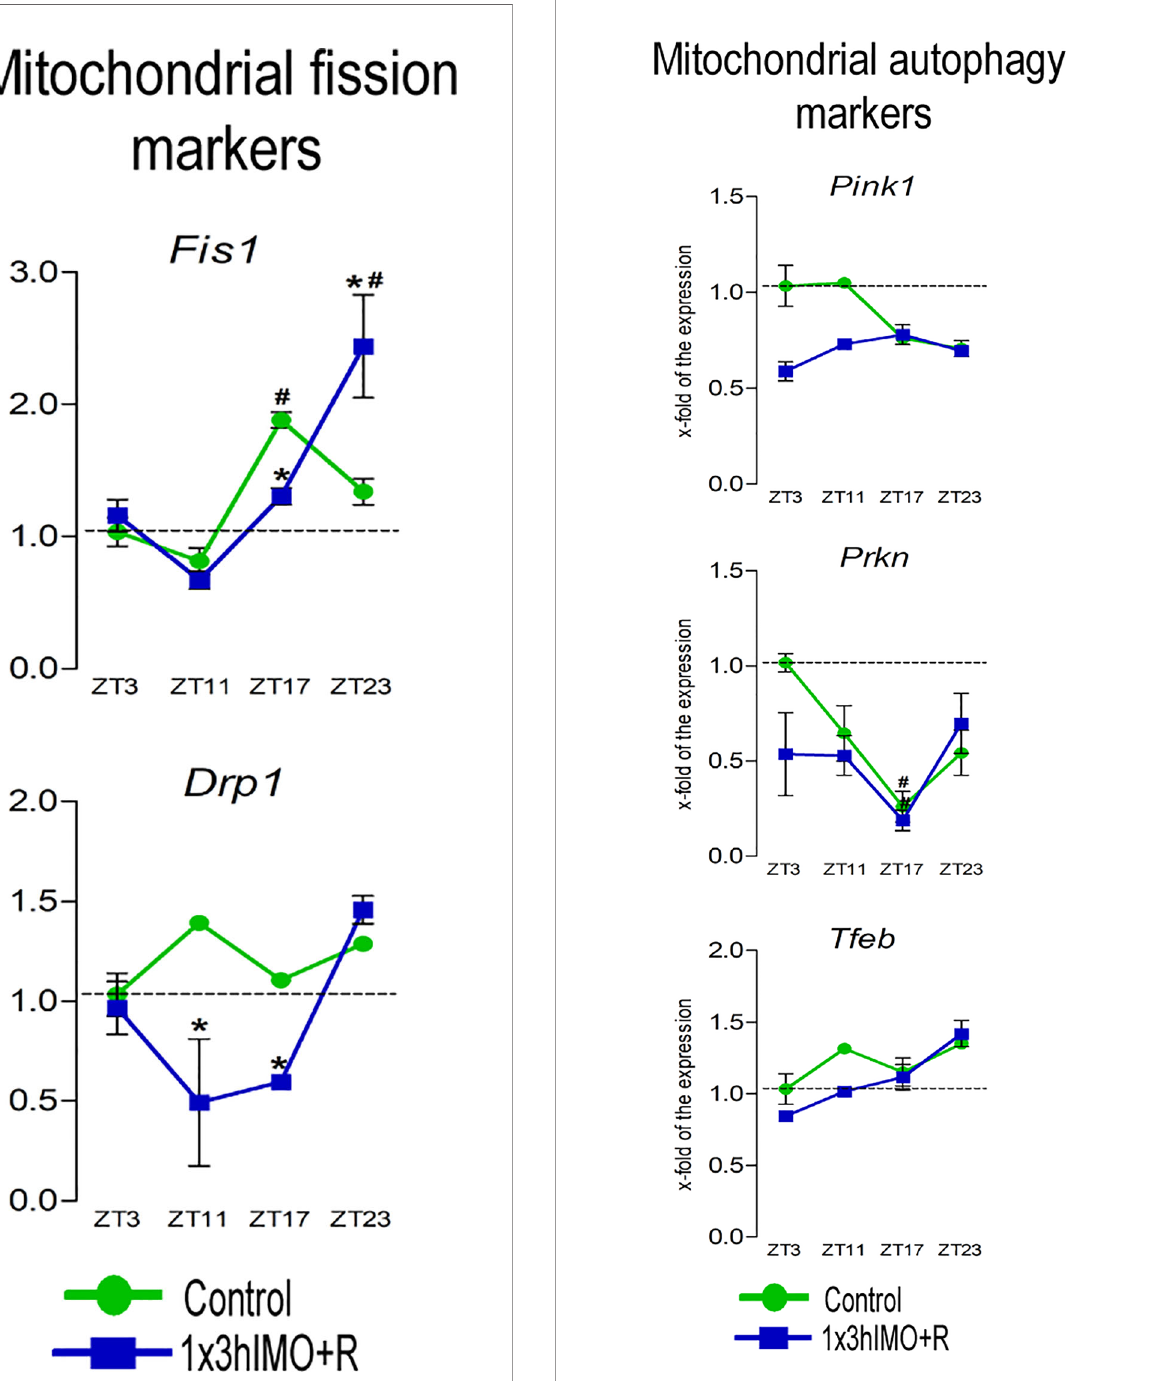
FIGURE 5 | Transcription of mitochondrial fi ssion markers is signi fi cantly changed in spermatozoa of acutely stressed adult rats in a time-dependent manner. Isolated RNA from spermatozoa of undisturbed and stressed rats was used for the analysis of the transcriptional pro fi le of markers of mitochondrial fi ssion. Data are presented as green dots connected a with green line for the control group, and blue squares connected with a blue line for the 1x3hIMO group, and are mean ± SEM values of two independent in vivo experiments. Statistical signi fi cance was set at p < 0.05: * vs. the control group of the same time point, # vs. the control group of ZT3 time point.